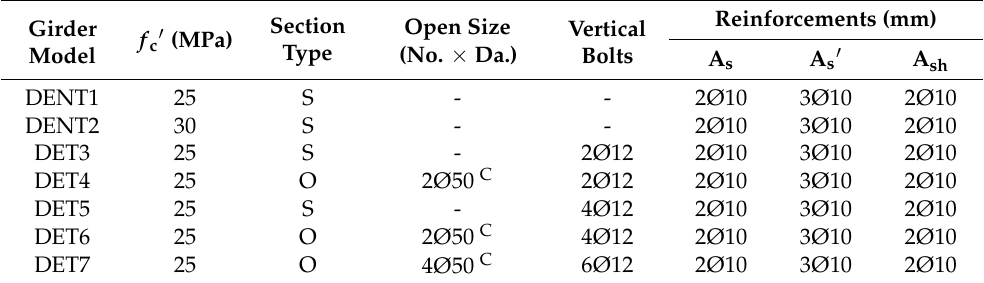
Table 1. Characteristics of the numerical RC girder models with dapped ends [39].